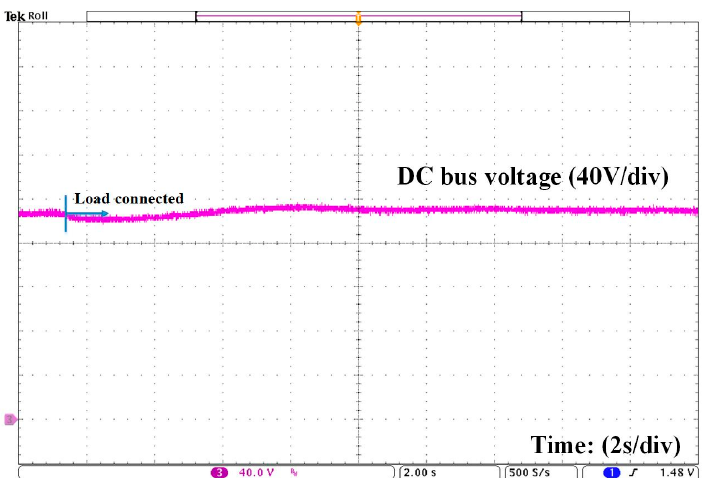
Figure 27. Connection of 300 W fluorescent lamps.